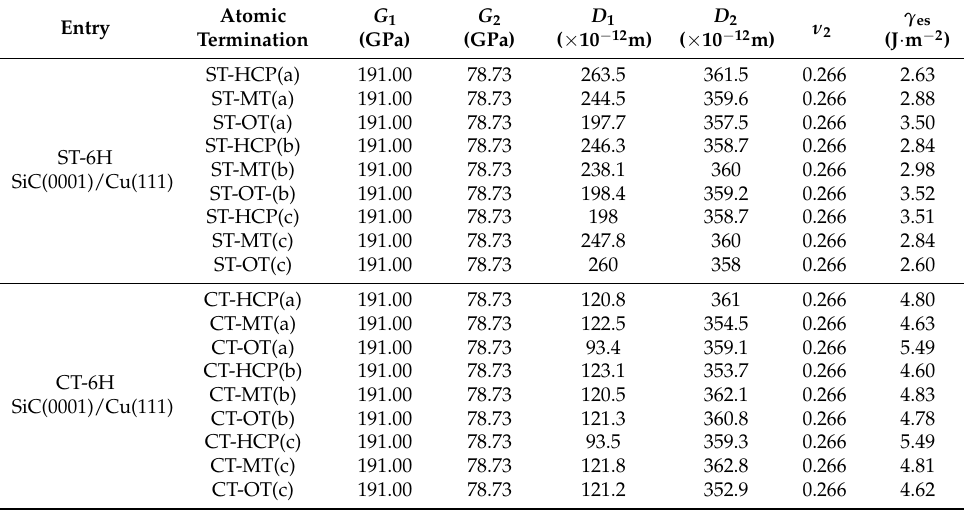
Table 4. The interfacial elastic energy of SiC(0001)/Cu(111).